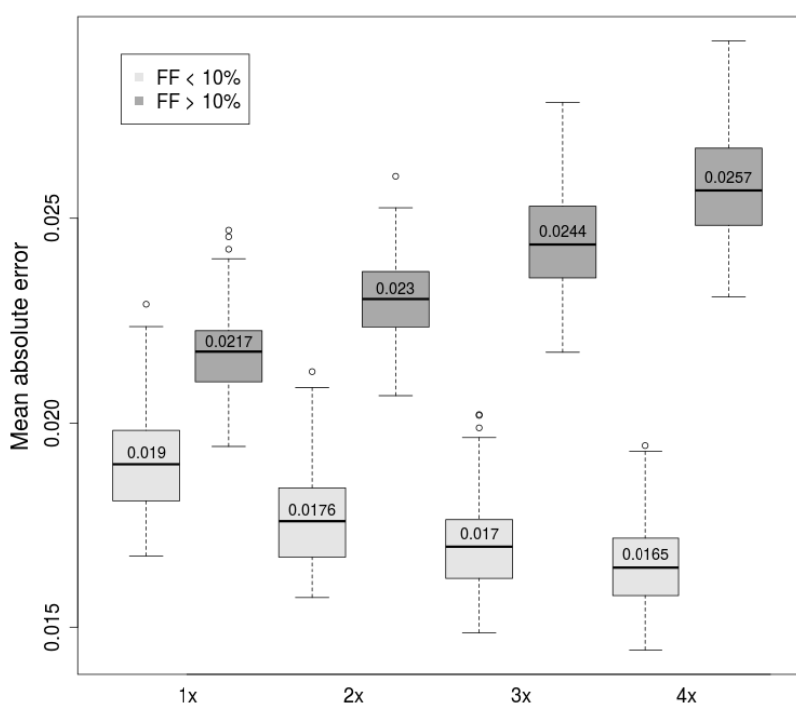
Figure 5. Mean absolute error Y-based FF and estimated FF using SVM method (lower is better). Only samples with FF < 10% used in training were sampled (weighted) with weights 2×, 3×, and 4×. Samples with FF > 10% were selected once. Scatterplots represented by linear regression with weighted samples are presented in the supplement (Supplementary Figures 1–3).